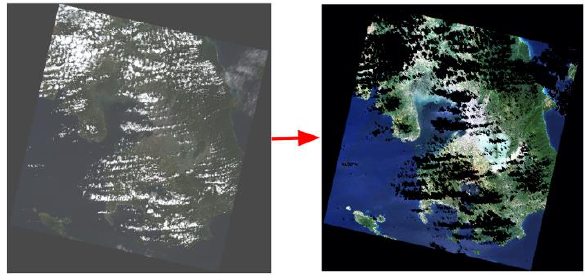
Figure 6 . Cloud masking of Landsat